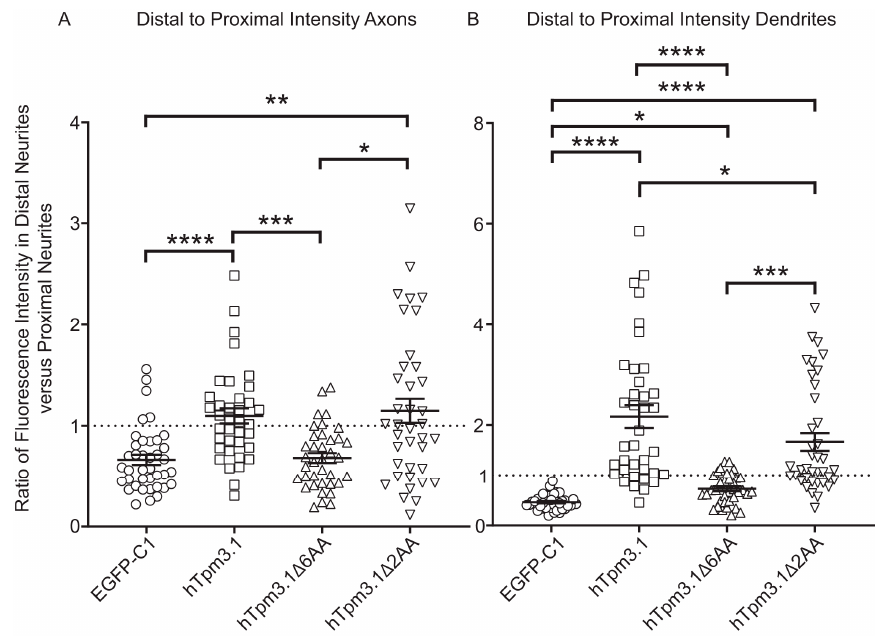
Figure 7. Effects of hTpm3.1 C-terminal truncation on segregation of hTpm3.1 to the tips of neu- rites. Mouse primary hippocampal neurons expressed EGFP-C1, hTpm3.1, hTpm3.1 ∆ 6AA